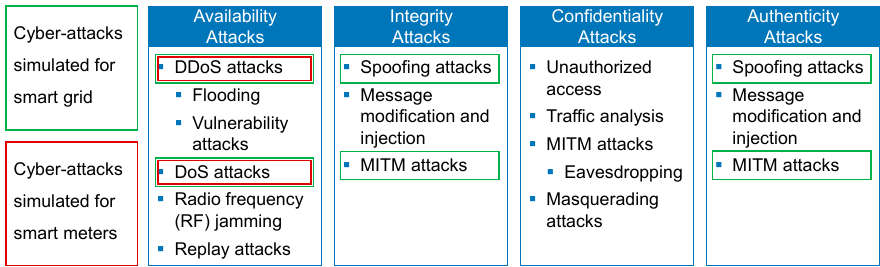
Figure 1. Formerly conducted simulations of cyber-attacks identified by Tellbach and Li [10].